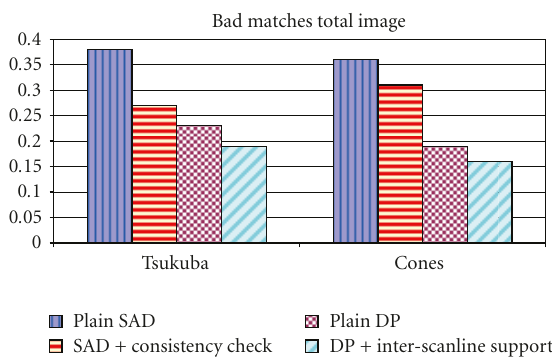
Figure 19: Comparison of the plain systems with the enhanced processors in terms of bad matching